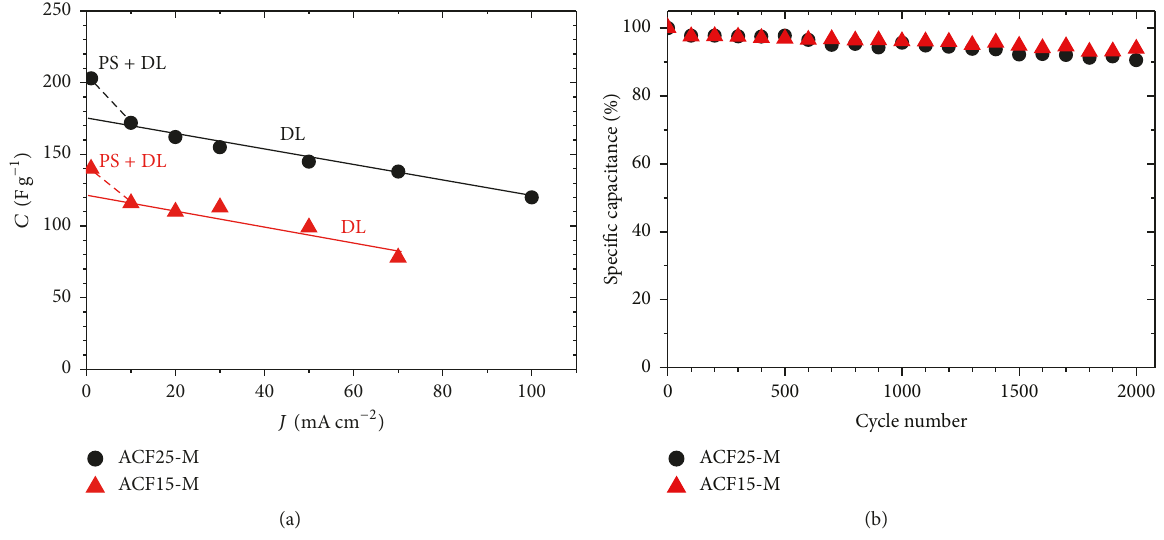
Figure 3: Electrochemical results obtained with two-electrode cells for the two monoliths ACF15-M and ACF25-M: (a) total specific capacitance versus current density; (b) dependence of the specific capacitance as a function of the cycle number at a current density of 40 mAcm −2